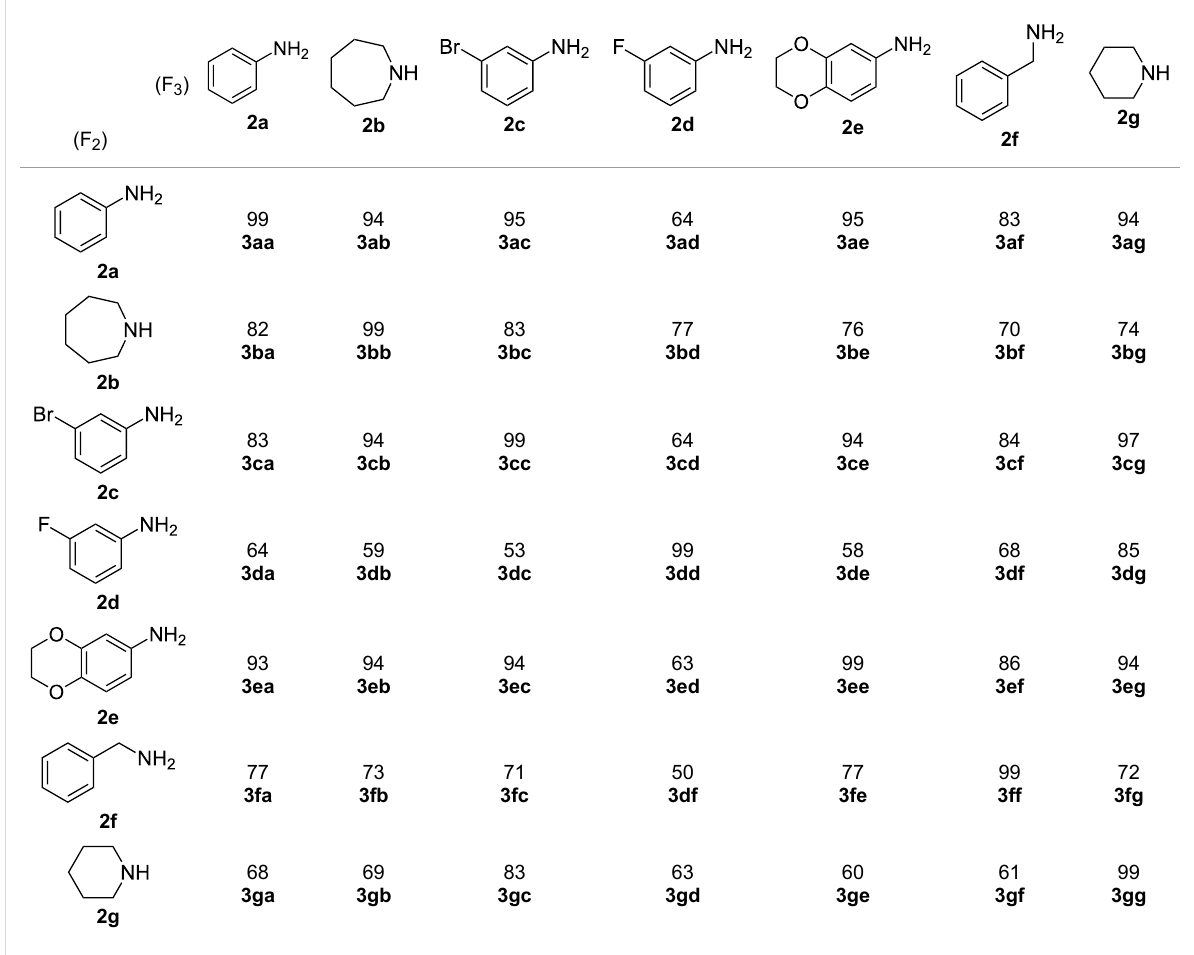
Table 4: Chemoselectivity (%) of the medium-throughput synthesis in continuous flow.